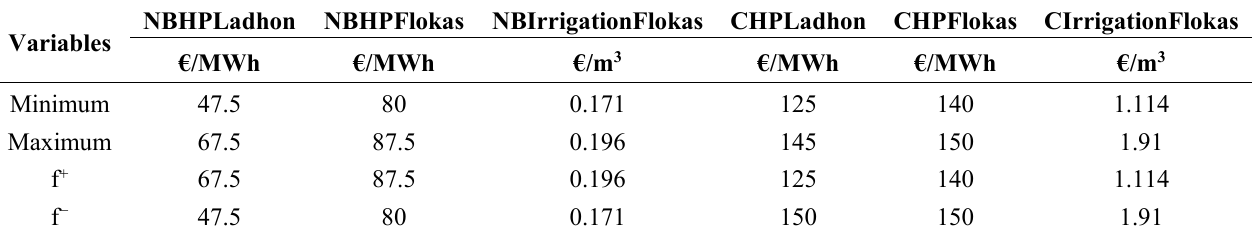
Table 13. Unit benefit and unit penalties for water allocation to the three water users for the application of the inexact two-stage stochastic programming model (ITSP) and uncertain variable combinations for the upper bound solution f + and the lower bound solution f − .